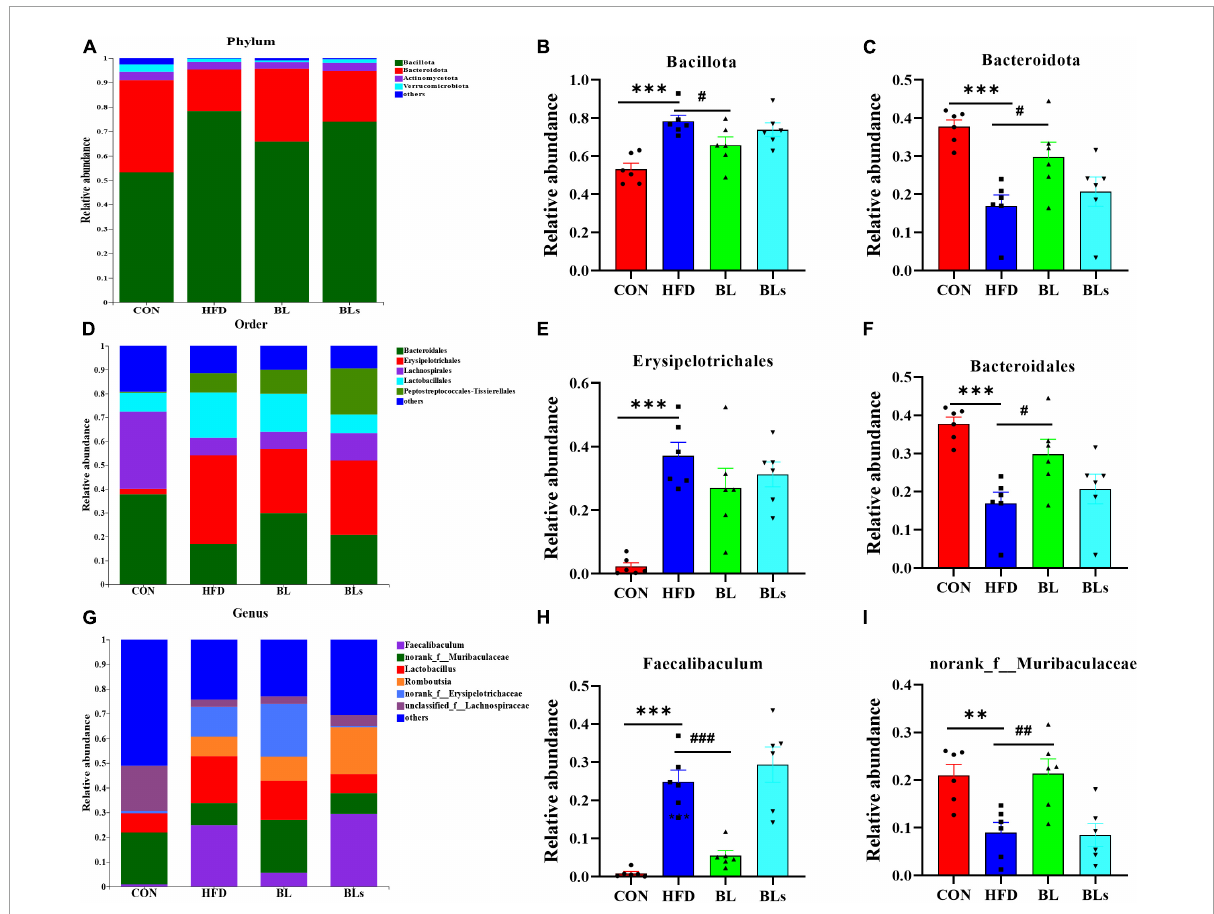
FIGURE7 Brevibacillus laterosporus BL1 treatment modulated gut microbiota composition in HFD-fed mice. (A) Gut bacterial taxonomic profiling at the phylum level. The relative abundances of Bacillota (B) and Bacteroidota (C) . (D) Gut bacterial taxonomic profiles at the order level. Relative abundance of Erysipelotrichales (E) and Bacteroidales (F) . (G) Gut bacterial taxonomic profiling at the genus level. Relative abundances of Faecalibaculum (H) and norank_f_ Muribaculaceae (I) . Data are presented as mean ± SEM ( n = 6) and analyzed using one-way ANOVA. Significant differences between HFD and CON are indicated by ∗∗ p < 0.01 and ∗∗∗ p < 0.001. Significant differences between HFD and BL are indicated by # p < 0.05, ## p < 0.01, and ### p <